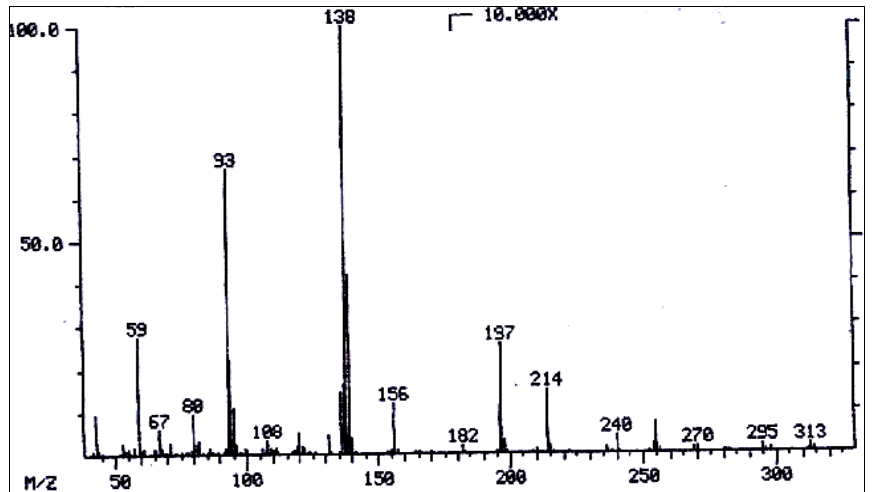
Figure 10. Mass spectrum of heliotrine.